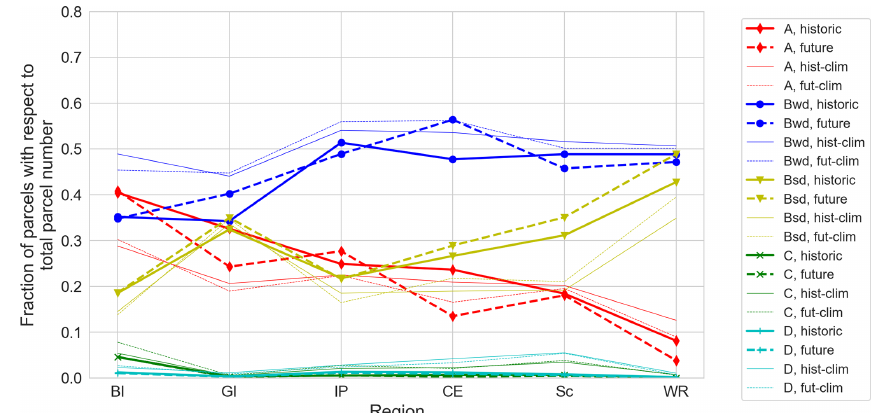
Figure 8. Fraction of trajectories that belong to the different clusters A, Bwd, Bsd, C and D introduced in Sect. 2.4 per region and time slice (solid lines belong to historic data and dashed lines to future data). Displayed are the fractions for heatwave trajectories (bold lines) as well as for the general summer (JJA) trajectories (thin lines). The regions are ordered according to the fraction in cluster A. Note that the lines connecting the different regions are only plotted to simplify the identification of the clusters and possess no physical